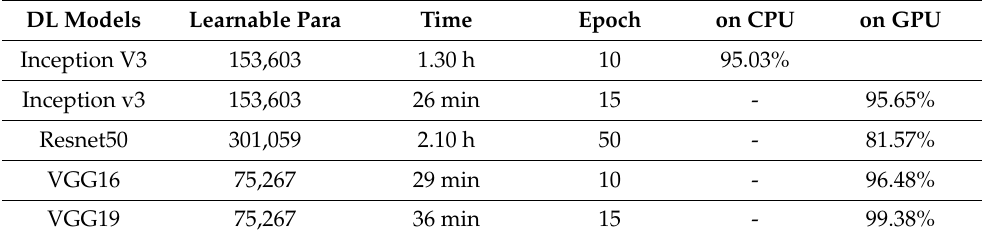
Figure 8. Experimental results on the classified diseases. Table 1. Classification performance of each